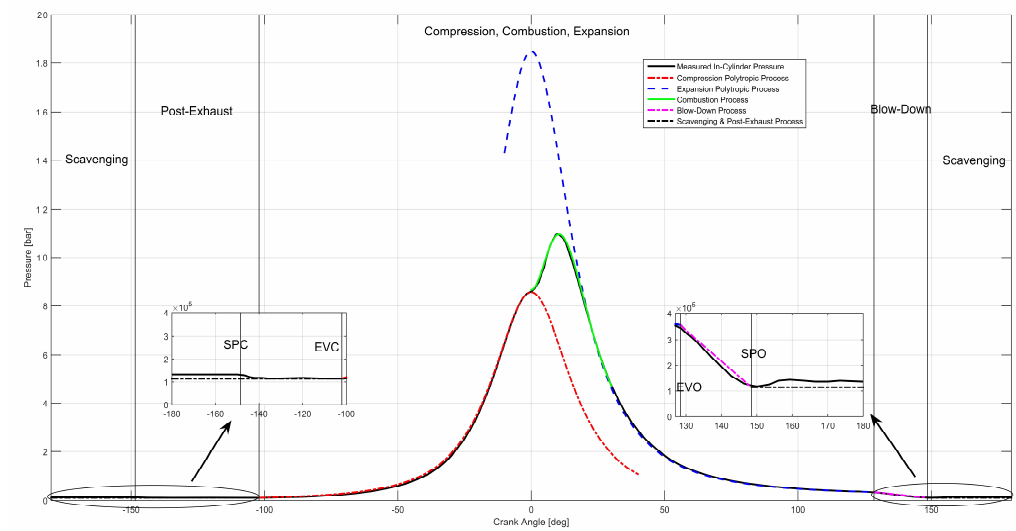
Figure 14. Basic idea of the cylinder pressure analytic model (SPC: Scavenging ports closing; SPO: Scavenging ports opening; EVC: Exhaust valve closing; EVO: Exhaust valve opening).